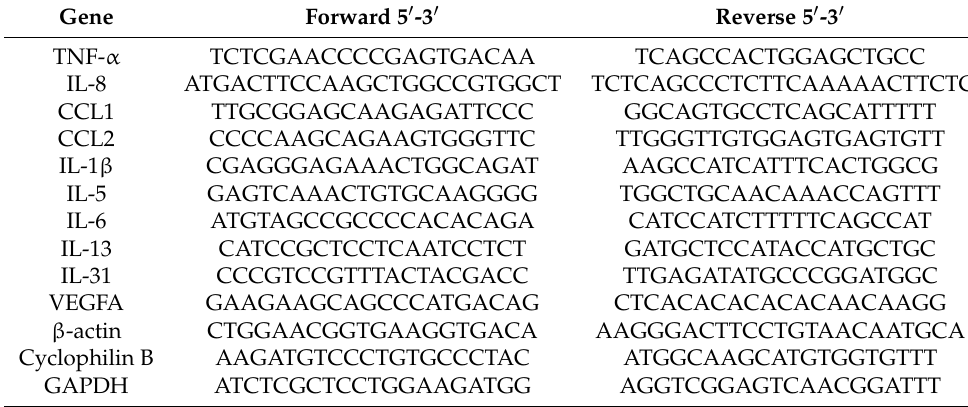
Table 2. Primer pairs used for